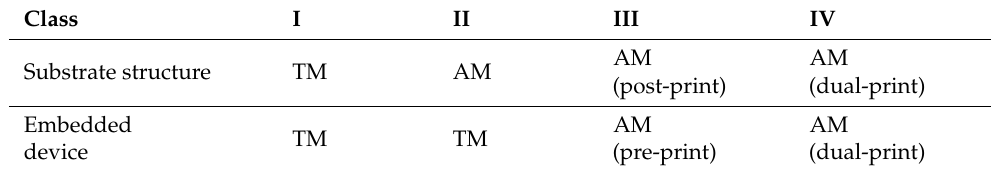
Table 4. Exemplary classification of electronics that are fully or partially 3D